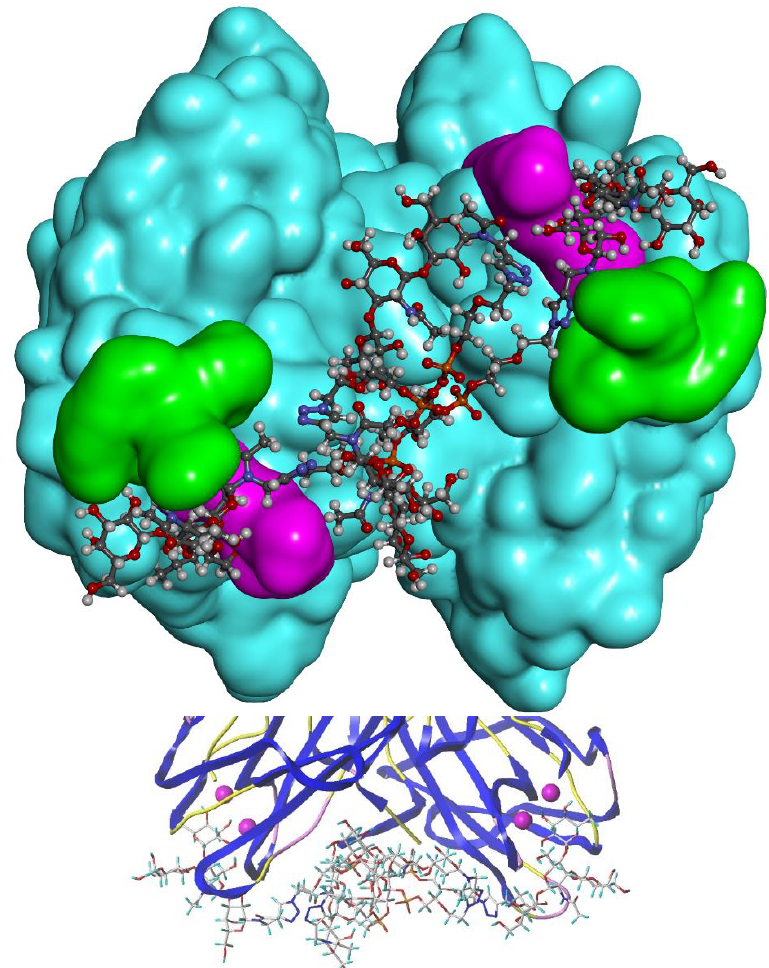
Figure 8. (top) Modelling of the interaction of G9-Lewis a with LecB. The two loops, V69-P73 and D96-D99, are in green and purple respectively. (bottom) Details of the interaction of G9-Lewis a with LecB.